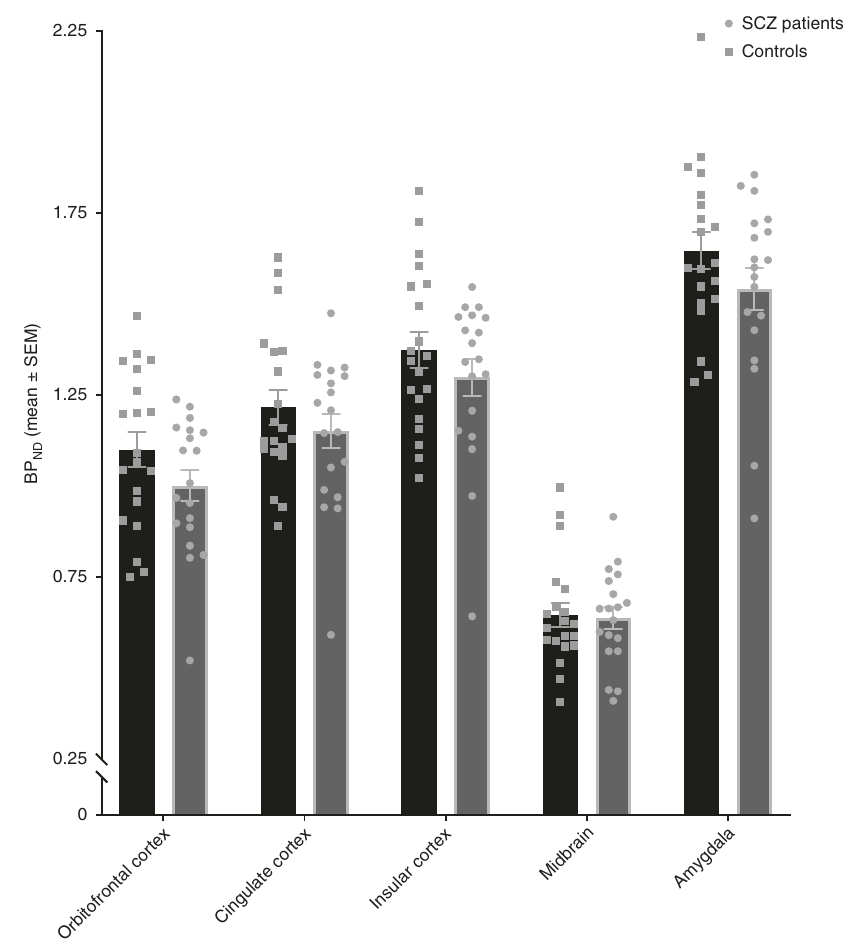
Fig. 2 [ 11 C]-carfentanil binding potentials in the hedonic network of healthy controls and schizophrenia patients (mean ± SEM). There was a signi fi cant group effect on BP ND measures in the hedonic network, with lower levels in patients (* p <